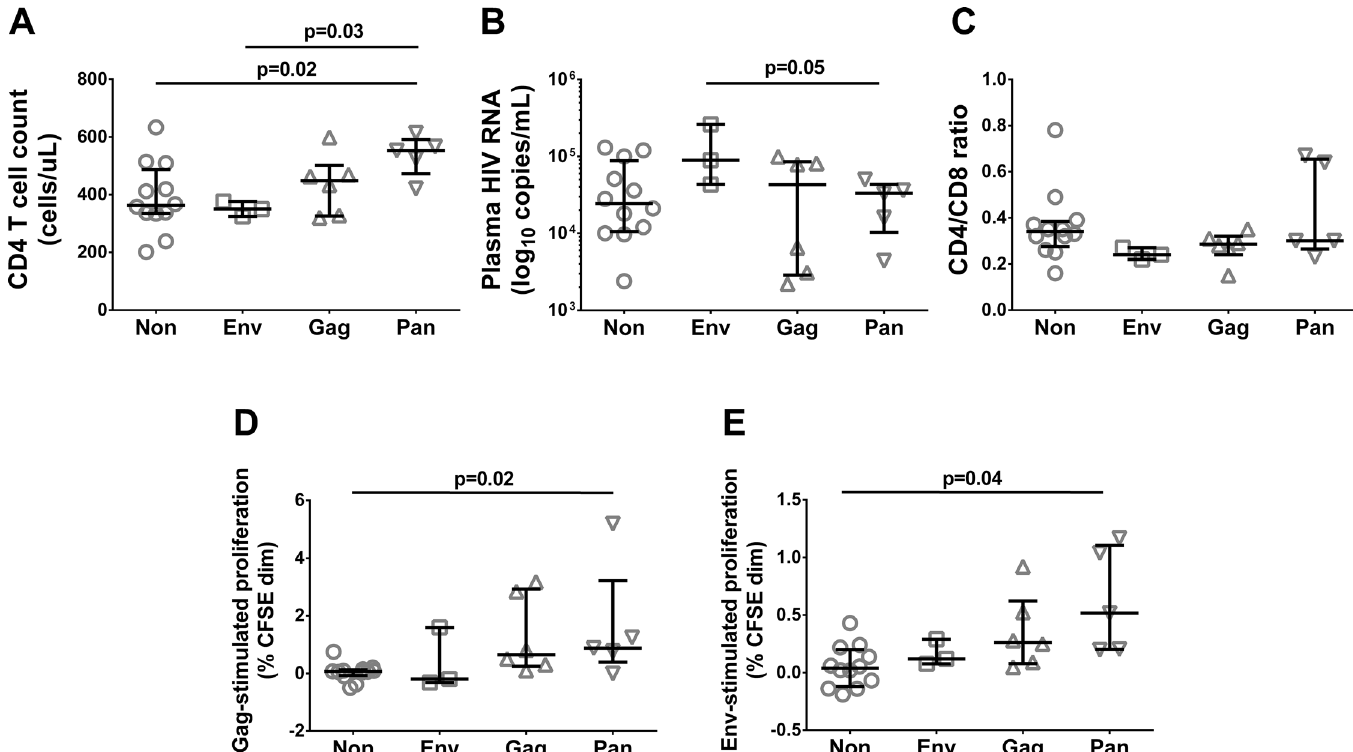
Fig 3. Clinical and immunological variables of regulator subgroups. (A) CD4 count, (B) Plasma HIV RNA, (C) CD4/CD8 ratio, (D) Gag-stimulated proliferation and (E) Env-stimulated proliferation, by regulator subgroup. Median and upper/lower quartiles indicated. P-values derived from unpaired